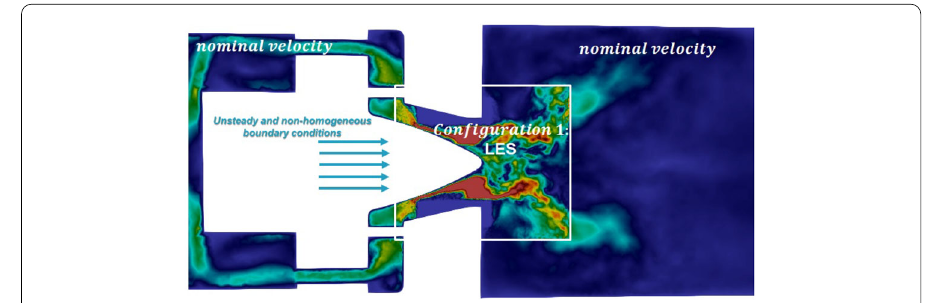
Fig. 26 An unsteady solution field of the hybrid simulation: the inlet unsteady and non-homogeneous boundary conditions on the left of the RFD are well reproduced thanks to the nominal dissipative reduced order solution: the LES in the RFD is stable